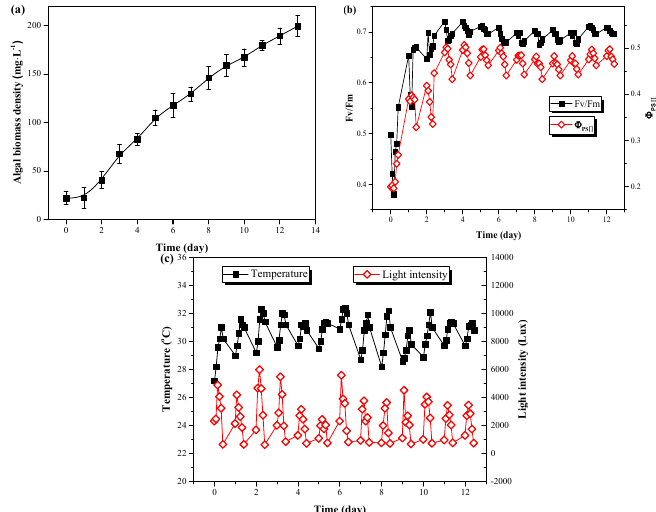
Figure 3. The changes of microalgal biomass density (a) and chlorophyll fluorescence parameters (b) as well as environmental parameters (c) during outdoor cultivation of C. vulgaris in LRP-enhanced raceway pond.